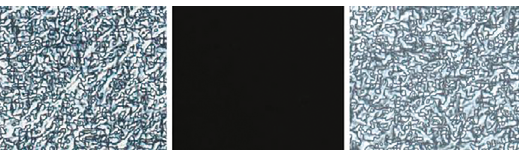
Figure 6. LC textures observed by PLM: (a) on heating; (b) isotropic and (c) on cooling.